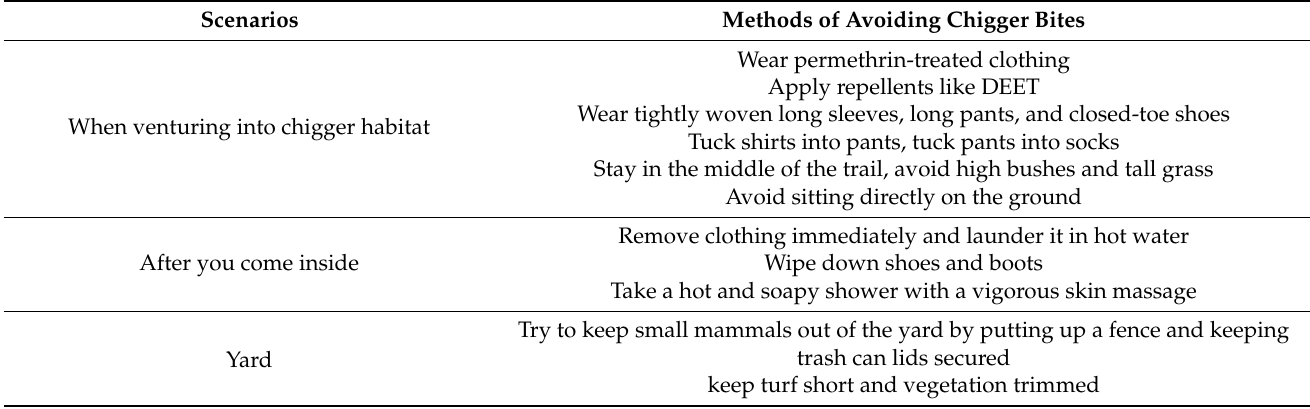
Table 2. Methods of avoiding chigger